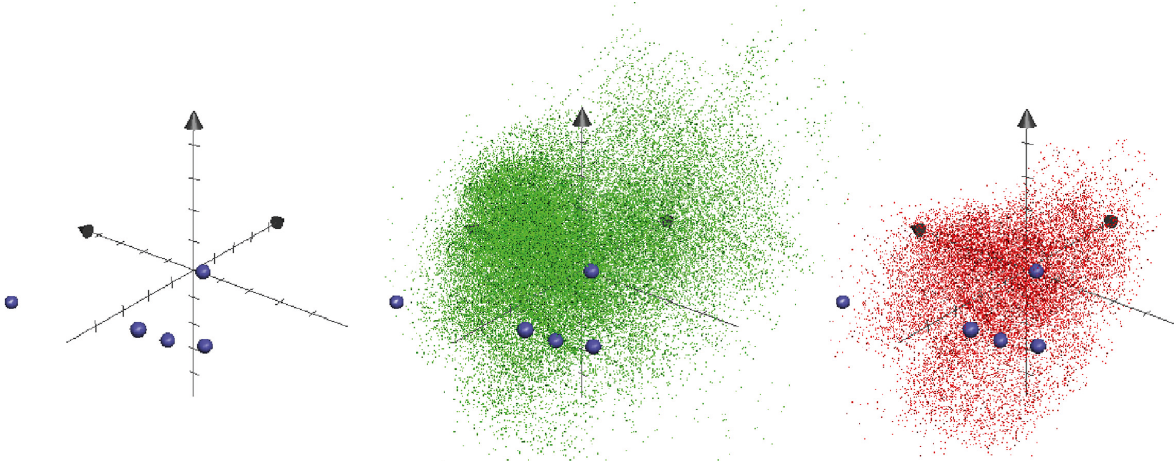
Figure 7: Ligand-based screening of odor-like compounds (blue circles: OBP ligands; green dots: biogenic compounds from zinc 12 database; red dots: selected compounds similar to OBP ligands in the chemical space). Table 2: Top virtual hits selected from structure-based virtual